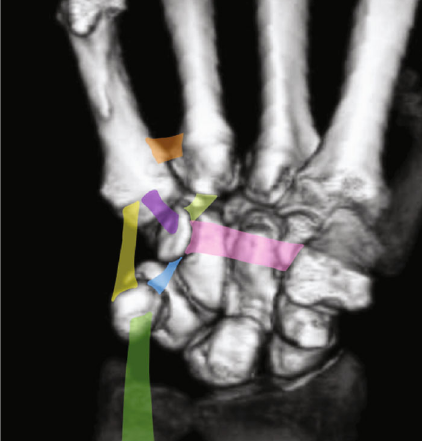
Figure 10: Ligamentous structure around the metacarpal bones, hamate hook, and pisiform. 1: fl exor carpi ulnaris. 2: volar fi fth metacarpal – pisiform ligament (pisometacarpal ligament). 3: volar fi fth metacarpal – hamate hook ligament. 4: volar fourth metacarpal ulnar base – hamate hook ligament. 5: metacarpal interosseous ligament (volar fourth metacarpal ulnar base – fi fth metacarpal radial base ligament). 6: pisohamate ligament. 7; transverse carpal